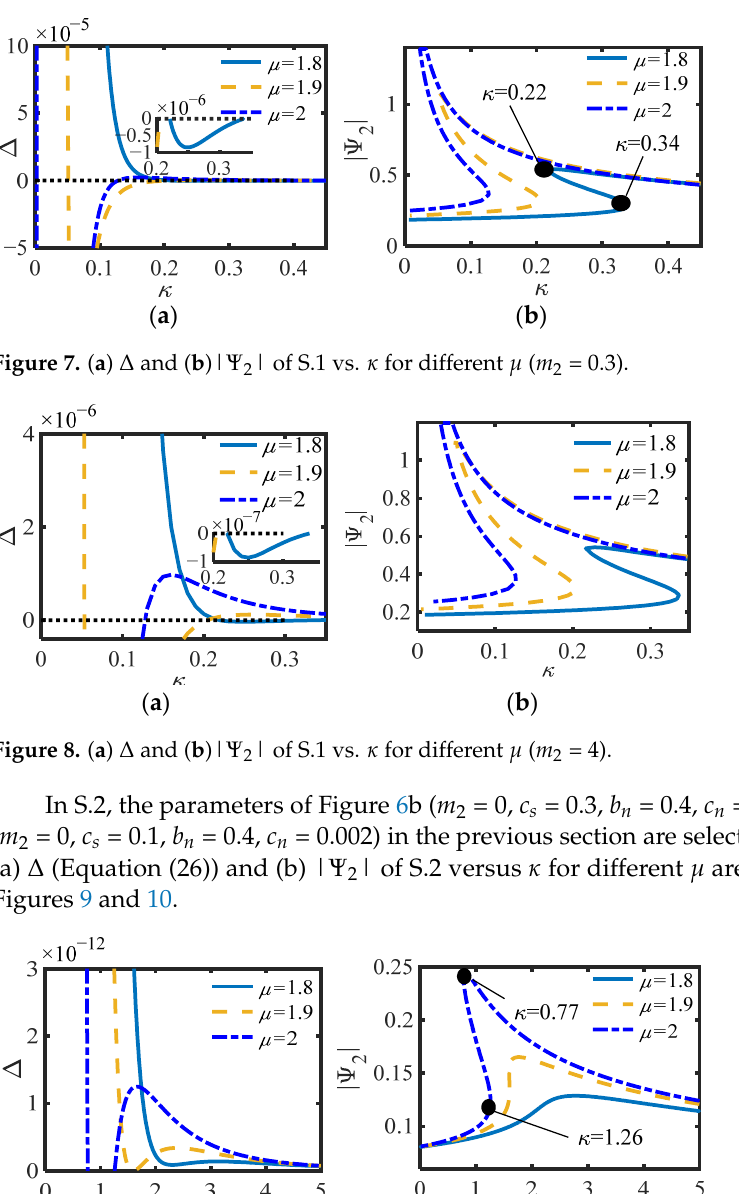
11 of 19 6a; Figure 6b shows the curve of Δ 2 versus b n for different μ ( c s = 0.3); Figure 6c shows the curve of Δ 2 versus μ for different b n ( m 2 = 0, c n = 0.002, b n = 0.4), and other parameters are the same as those in S.1. ( a ) ( b ) ( c ) Figure 6. ( a ) Δ 2 vs. μ and b n for different c s; ( b ) Δ 2 vs. b n for different μ ( c s = 0.3); ( c ) Δ 2 vs. b n for different c s ( m 2 = 0, cn = 0.002, b n = 0.4) . As can be seen from Figure 6a,c, in the case of other parameter phase diagrams, the larger the c s, the larger the range of Δ 2 greater than zero. It can be seen from Figure 6b that the change law of the curve is consistent with that of Figure 4b, which shows that the inertance ( b n ) of the series inerter can nominally replace m 2 . However, for S.1 the change law is different from that of the curve in Figure 4b, which shows that b n cannot simply replace m 2 when the inerter is connected in parallel. 4.2. Verification of Equilibrium Point Discriminant